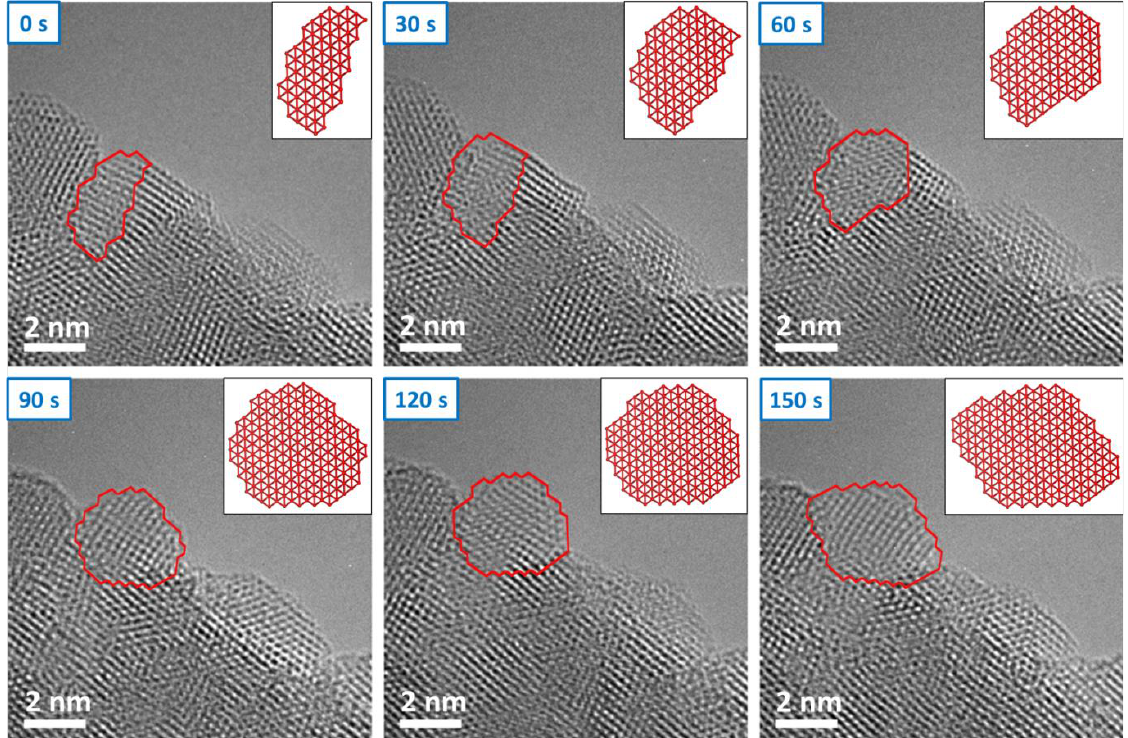
Figure 4. HRTEM image series of the beam irradiation effect on the Cu 2 O sample exfoliated with isopropanol. The growth of the new structure, identified as Cu, is shown on subsequent images, with an inset of the structure model of the Cu crystal.